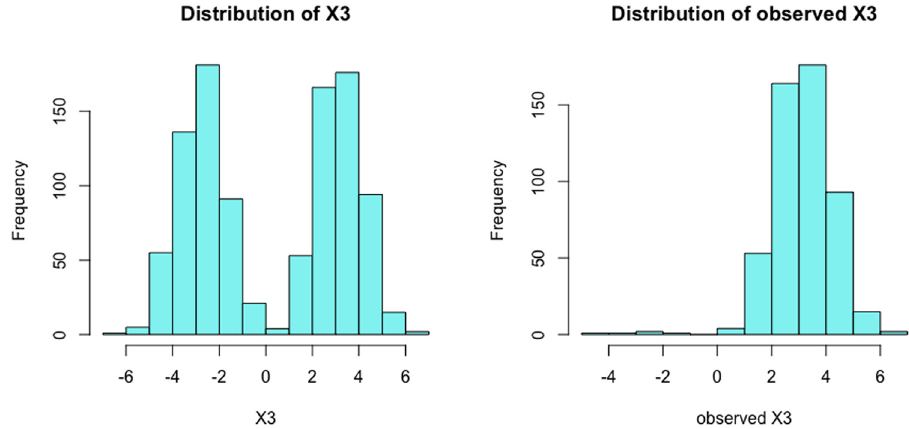
Figure A1: X 3 is symmetric about zero. However, sampling distribution of the observed X 3 is skewed to the left as samples with negative X 3 values have dropped out.